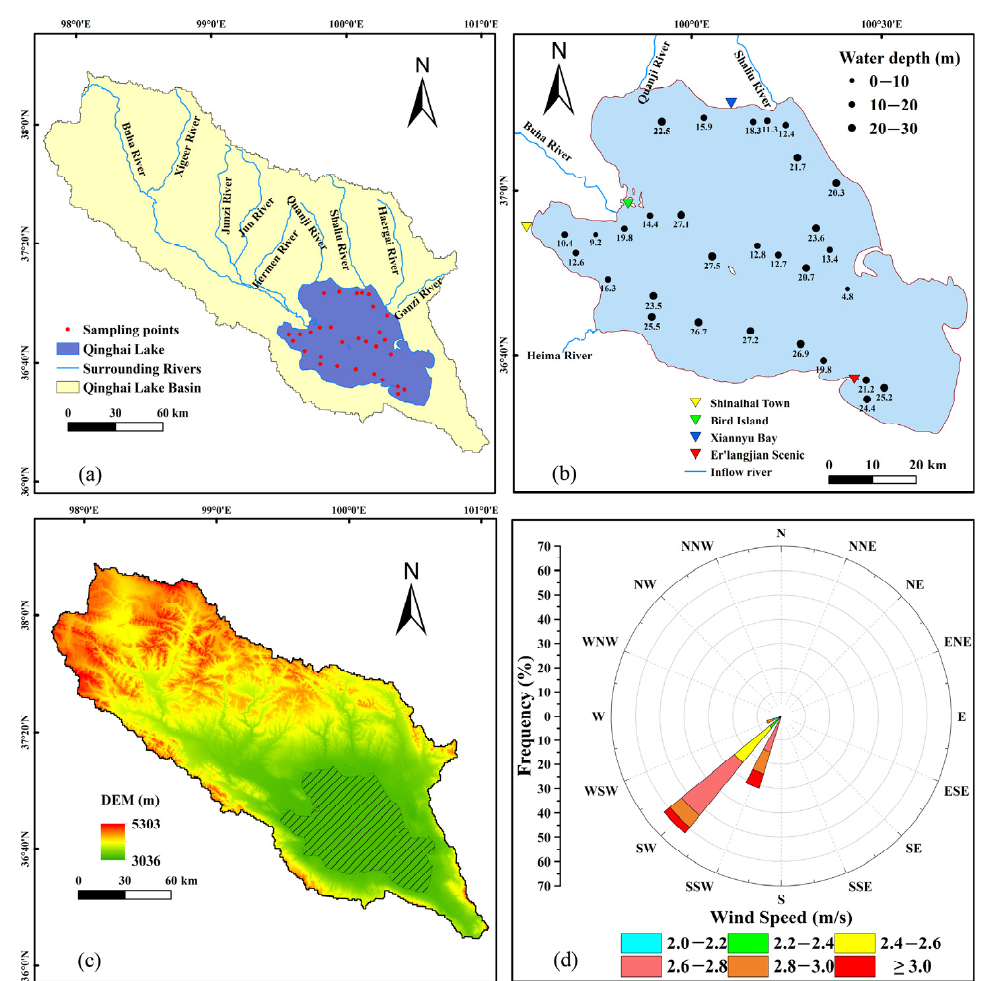
Figure 1. The information of Lake Qinghai and field sampling: ( a ) geographic distribution of Lake Qinghai and the basin; ( b ) spatial distribution of sampling spots and water depth in September 2019; ( c ) the digital elevation map provided by Shuttle Radar Topography Mission (SRTM); ( d ) wind rose of Lake Qinghai.